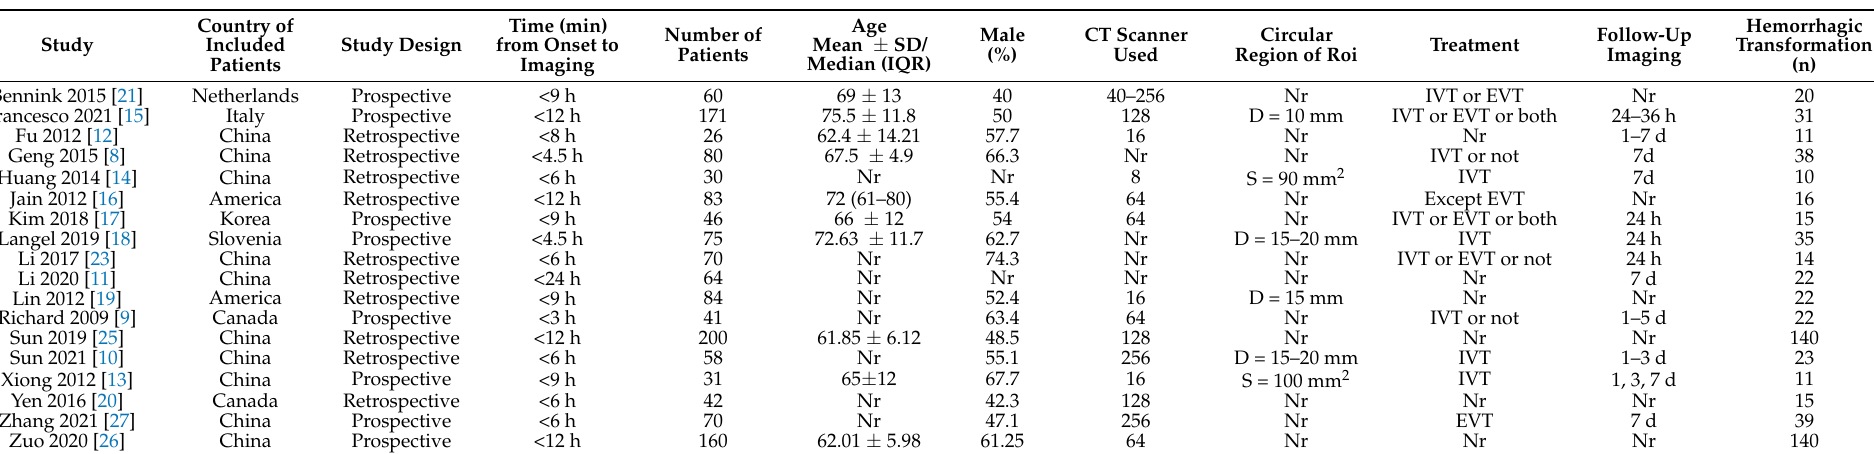
Table 1. Characteristics of included